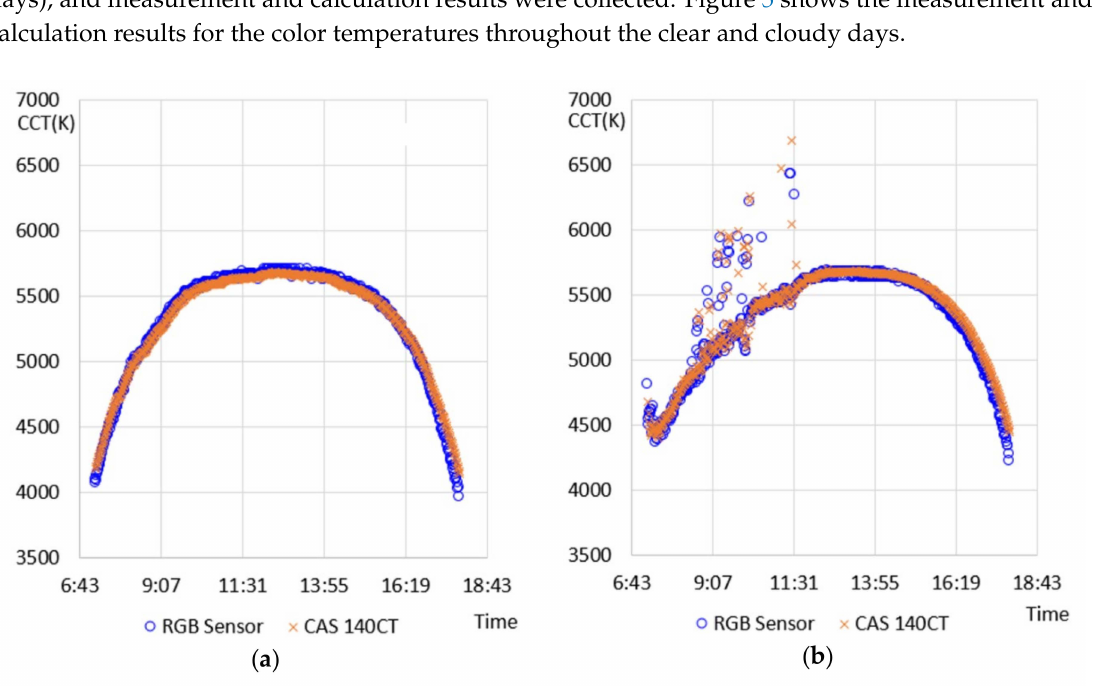
Figure 5. Comparison of measurement and calculation results for color temperatures. ( a ) Clear